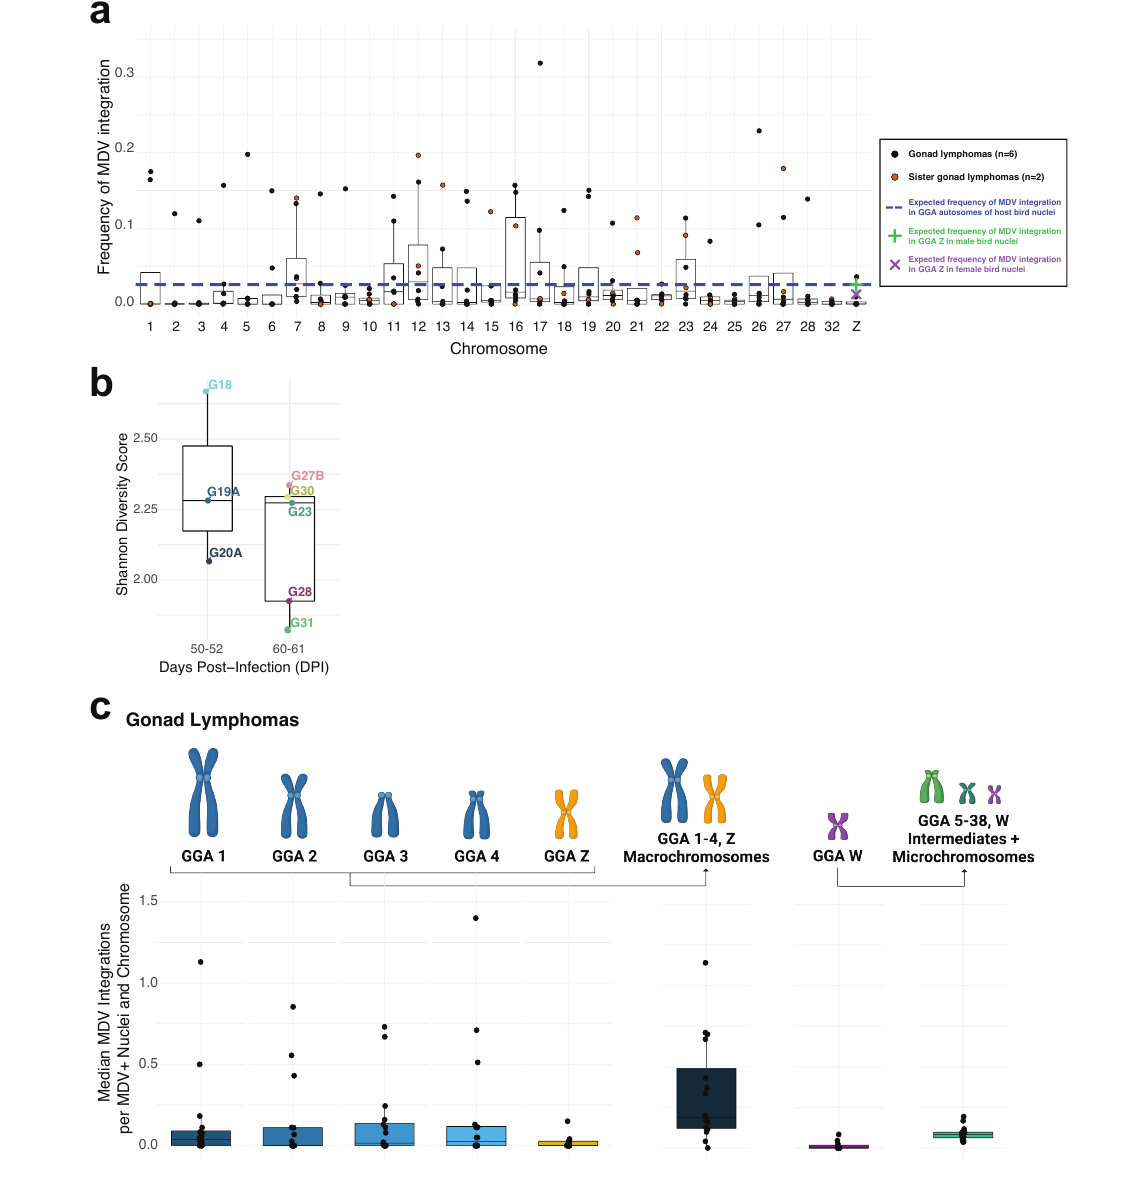
Figure 5. Cross-experiment analysis reveals no statistically significant MDV integration ‘hotspots’ amongst host chro- mosomes and lower diversity of MDV integration profiles over time in MD gonad lymphomas: ( a ) Observed versus expected frequencies of MDV integration events ( y axis) mapped to individual host chromosomes ( x axis) within MD gonad lymphomas (dots) are shown. Boxed line depicts median value, box depicts interquartile range (IQR), and whiskers depict IQR+/ − 1.5*IQR. Yellow dots indicate the two gonad lymphomas from the same host MDV-infected bird (bird A; see Figure 1a). The horizontal dashed blue line represents the expected MDV integration frequencies, assuming a random/unbiased process of integration, for autosomal chromosomes (GGA 1-28, 32). The green ‘+’ and purple ‘X’ symbols indicate expected frequency of random MDV integration for GGA Z in male bird nuclei (ZZ) and female bird nuclei (ZW), respectively. Gonad lymphoma data shown are from study parts II-III (see Figure 1a; n = 8); ( b ) Shannon diversity score of MD gonad lymphomas collected within the time ranges 50–52 dpi ( n = 3) versus 60–61 dpi ( n = 5). Gonad lymphomas are from study parts II and III (see Figure 1a). A higher score indicates a greater diversity, in terms of MDV integration profiles, of the FISH-analyzed cell population within a lymphoma. Boxed line depicts median values, box depicts interquartile range (IQR), and whiskers depict IQR+/ − 1.5*IQR. p = 0.28; ( c ) Median MDV integrations per MDV + nuclei into each chromosome (individually for GGA 1, 2, 3, 4, Z, W) and chromosome category (collectively for macrochromosomes or GGA 1-4, Z and intermediates + microchromosomes or GGA 5–38, W) in gonad lymphomas from study parts I-III (see Figure 1a; n = 21). Medians were adjusted to number of chromosomes in category, where